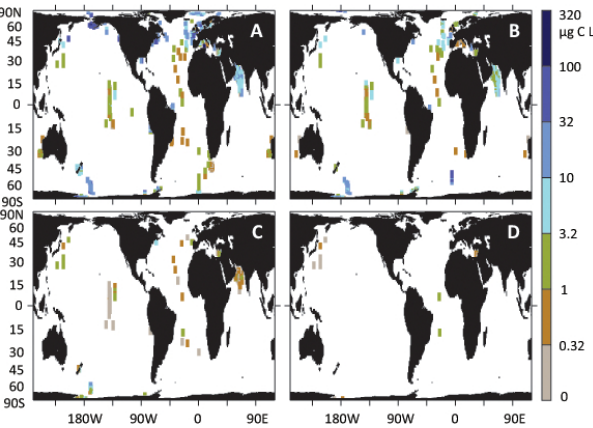
Figure 1. Microzooplankton biomass [ µ gCL − 1 ]. (A) 0–40m, (B) 40–112.5m, (C) 112.5–225m, (D) > 225m.